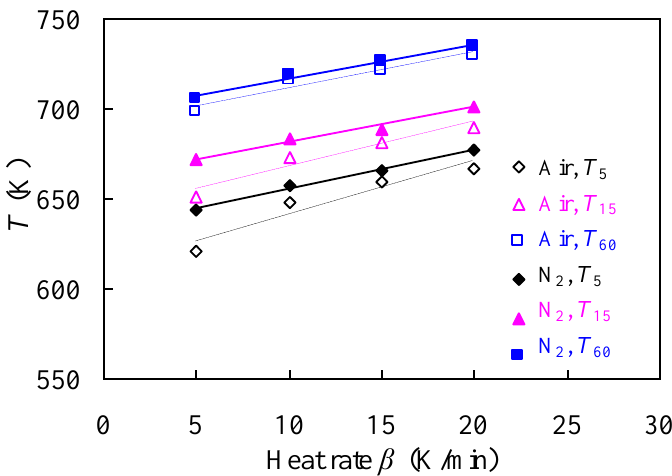
Figure 3. Effect of heating rate β on specific degradation temperatures of the nylon-6 string waste sample in oxidative air and inert N 2 .